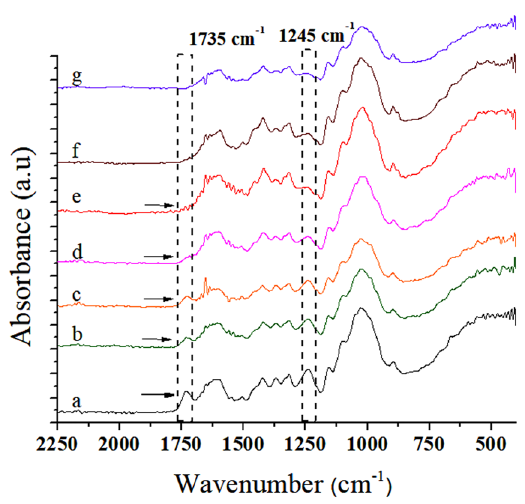
Figure 10. Comparative FT-IR analysis of sisal fibre: a) untreated; treated with NaHCO for b) 24 h c) 96 h and d) 168 h; treated with 3 Na CO for e) 24 h f) 96 h and g) 168 2 3